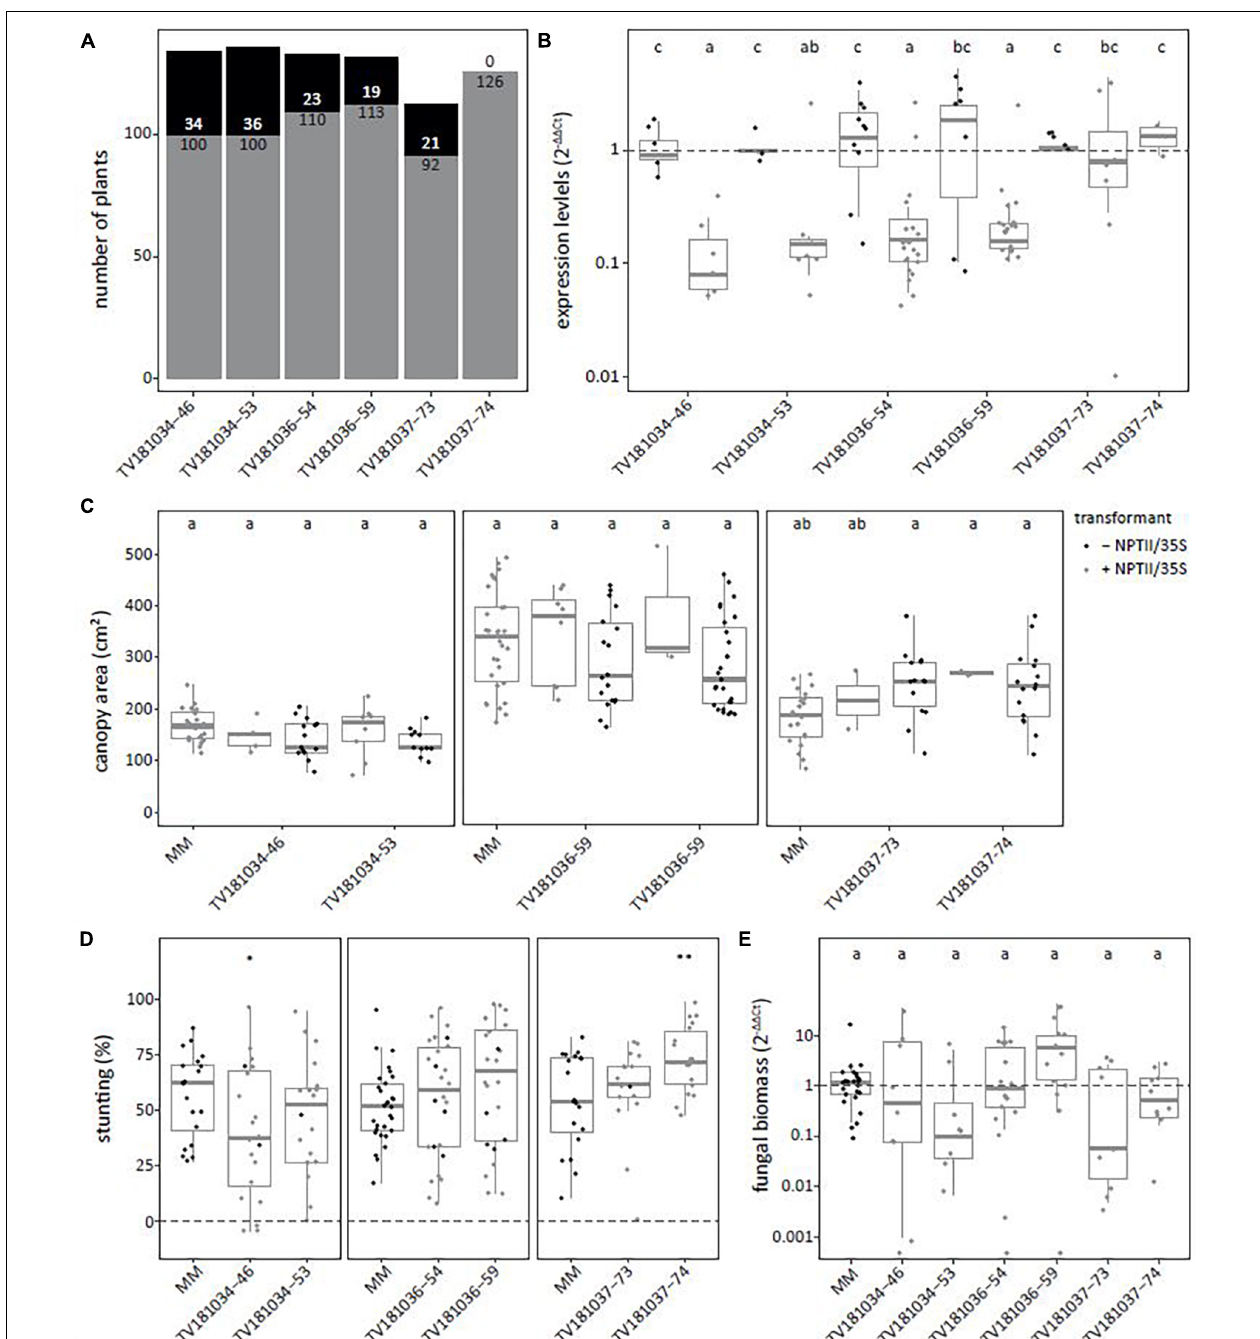
FIGURE 3 | Loss of susceptibility to V. dahliae was not confirmed in all SlWAT1 T3 RNAi families. (A) Total number of plants with (gray) and without (black) the silencing construct for six T3 RNAi families which were obtained from three different T2 RNAi families. (B) Expression levels of T3 SlWAT1 RNAi families relative to plants without the silencing construct (– NPTII/35S, gray) and normalized using 2 − (cid:49)(cid:49) Ct to SlEF1 α with n ≥ 4 per family with (gray) and without (black) the silencing construct (ANOVA with Fisher’s unprotected LDS with p = 0.05 on (cid:49) Ct values). (C) Canopy area (cm 2 ) of mock-inoculated plants at 21 days post inoculation (dpi) for T3 SlWAT1 RNAi families with (gray) and without (black) the silencing construct. Data from two independent experiments with n ≥ 2 (ANOVA with Fisher’s unprotected LSD, p = 0.05). (D) Stunting (%) of V. dahliae -inoculated plants when compared with the average stunting of mock-inoculated plants per genotype at 21 dpi. Box plots represent data with n ≥ 8 plants per experimental repeat ( t -test when compared with MM with * p < 0.05 and ** p < 0.01). (E) Relative fungal biomass in the stems of RNAi plants at 21 dpi with V. dahliae . This was calculated as the ratio of the V. dahliae ITS gene amplification in comparison with the tomato SlRUB gene ( Supplementary Table 1 ) and normalized the V. dahliae- inoculated MM plants using 2 − (cid:49)(cid:49) Ct on a log10 scale with n ≥ 7 per family (ANOVA with Fisher’s unprotected LSD, p = 0.05 on (cid:49) Ct). a–c: Genotypes having average values with a letter in common are not statistically significant different (at P = 0.05).